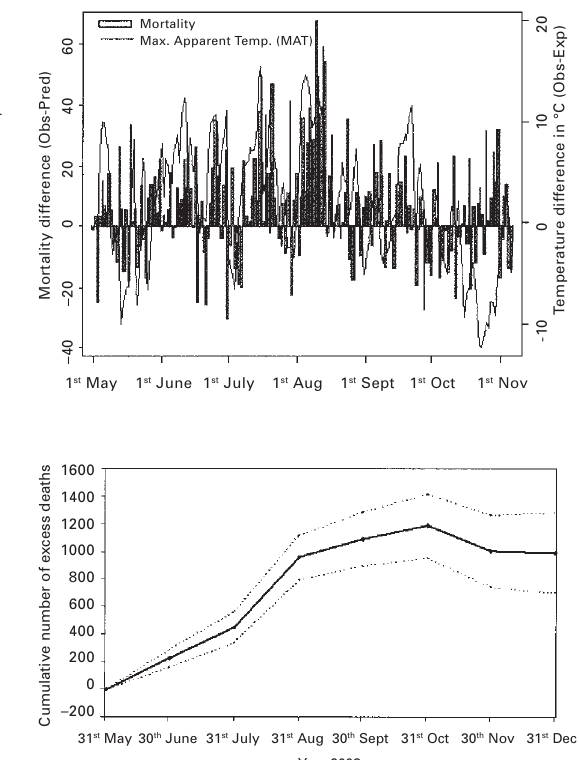
from June to Decem- ber 2003 and its 95% confidence